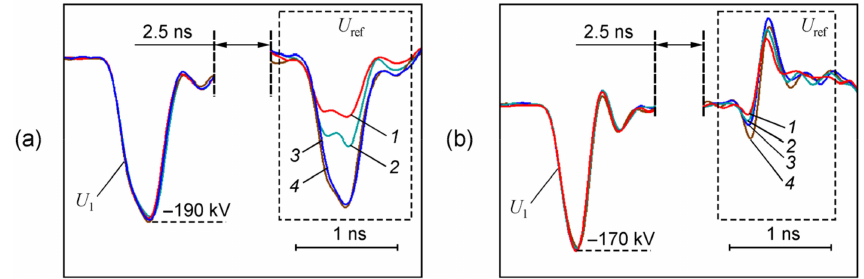
Figure 3. Typical oscillograms of incident ( U 1 ) and reflected ( U ref ) voltage pulses obtained in the modes of the MICD operation in vacuum ( a ) and at atmospheric pressure ( b ). 1; 2—graphite cathode; the gap D = 10 and 30 mm, respectively. 3; 4—steel cathode; the gap D = 10 and 30 mm,